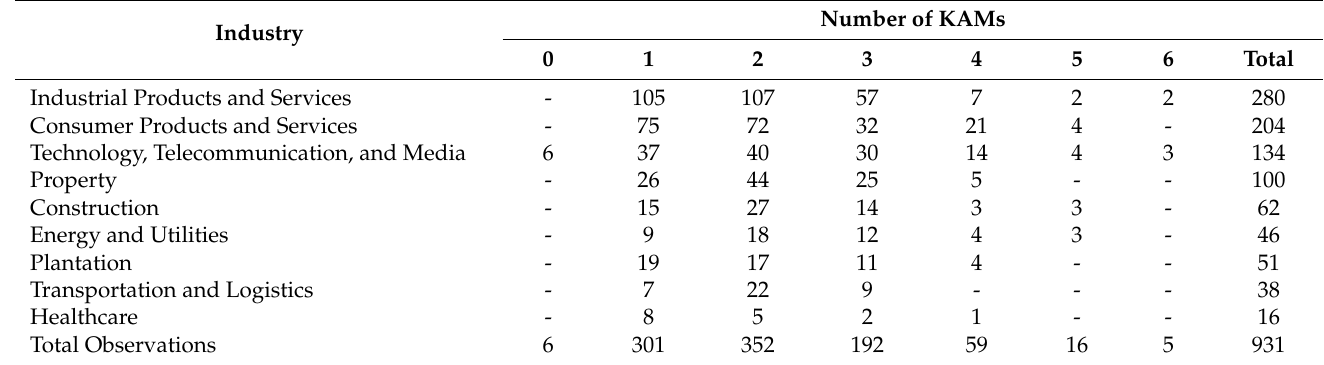
Table 5. Number of KAMs based on type of